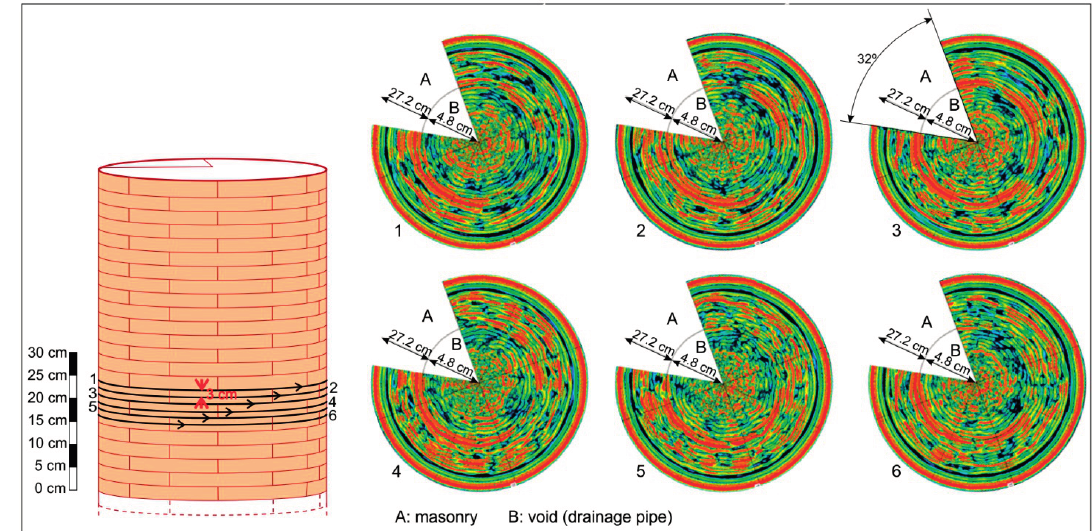
Figure 6. Radar images from six of the adjacent circular